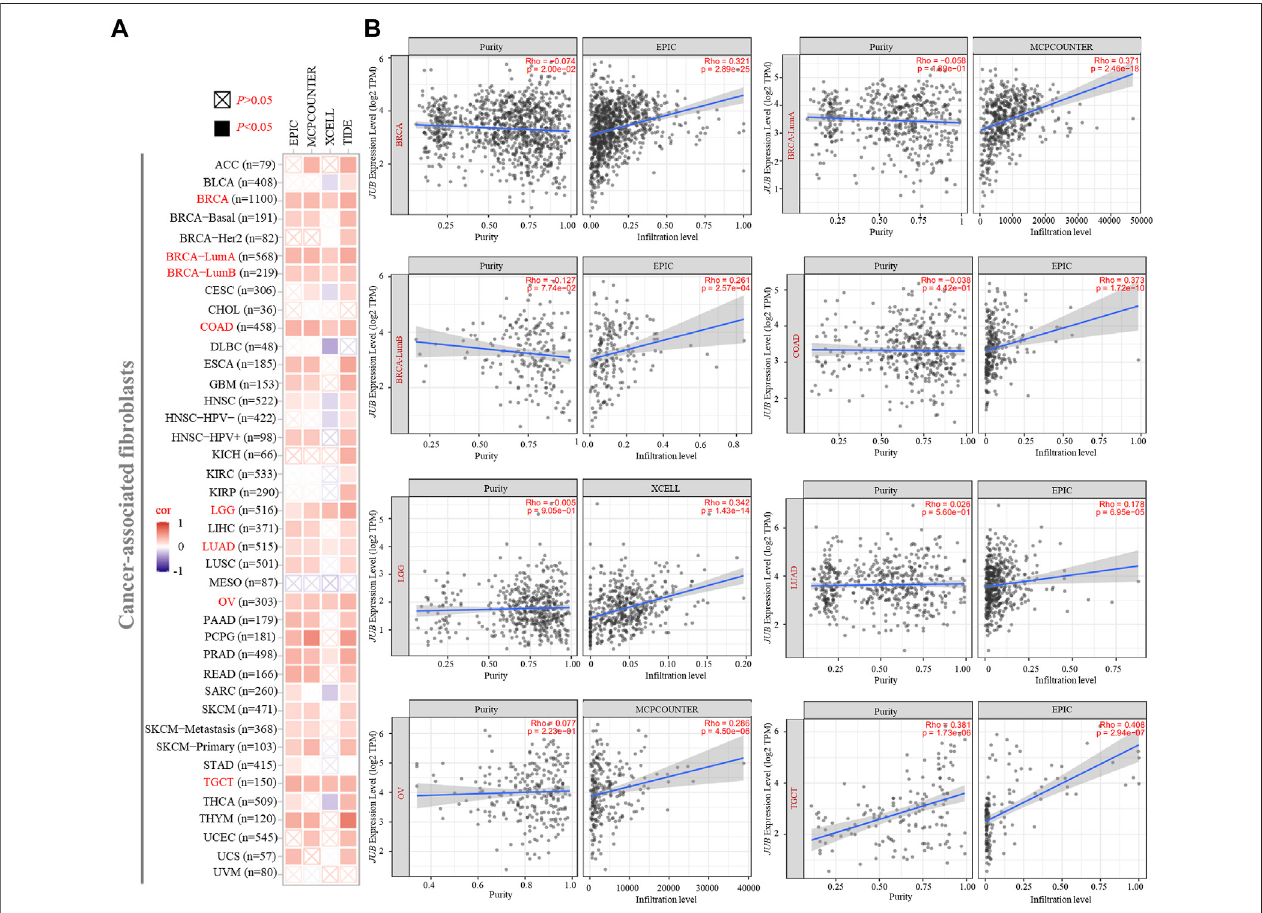
FIGURE 7 | Correlation analysis between the AJUBA gene expression and immune in fi ltration of cancer-associated fi broblasts (CAFs). Different algorithms analyzed potential correlations in (A) the AJUBA expression level and (B) in fi ltration of CAFs among different cancer types based on TCGA database.